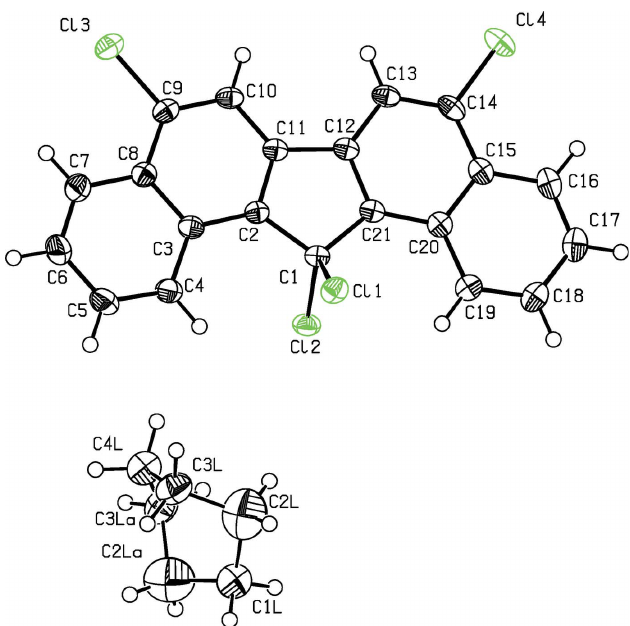
Figure 1 Perspective view of the title compound. Displacement ellipsoids are drawn at the 50% probability level. Only one component of the disordered cyclohexane solvent molecule is shown.